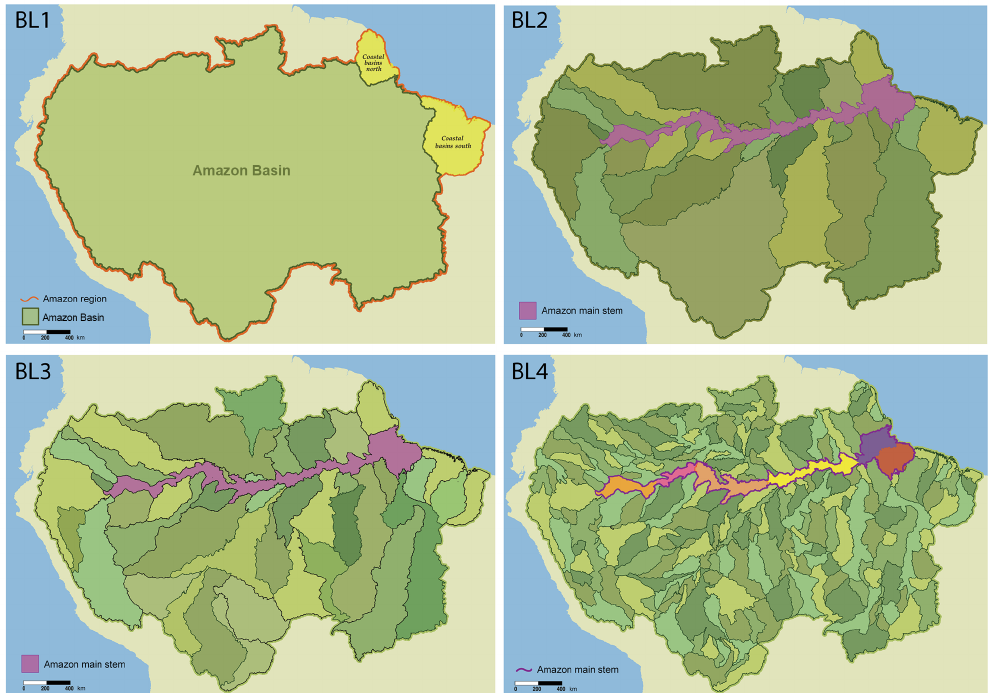
Figure 1. Cartographic representation of the first four levels of the classification of the Amazon and adjacent coastal basins (south and north): BL1, BL2, BL3 and BL4. BL: basin